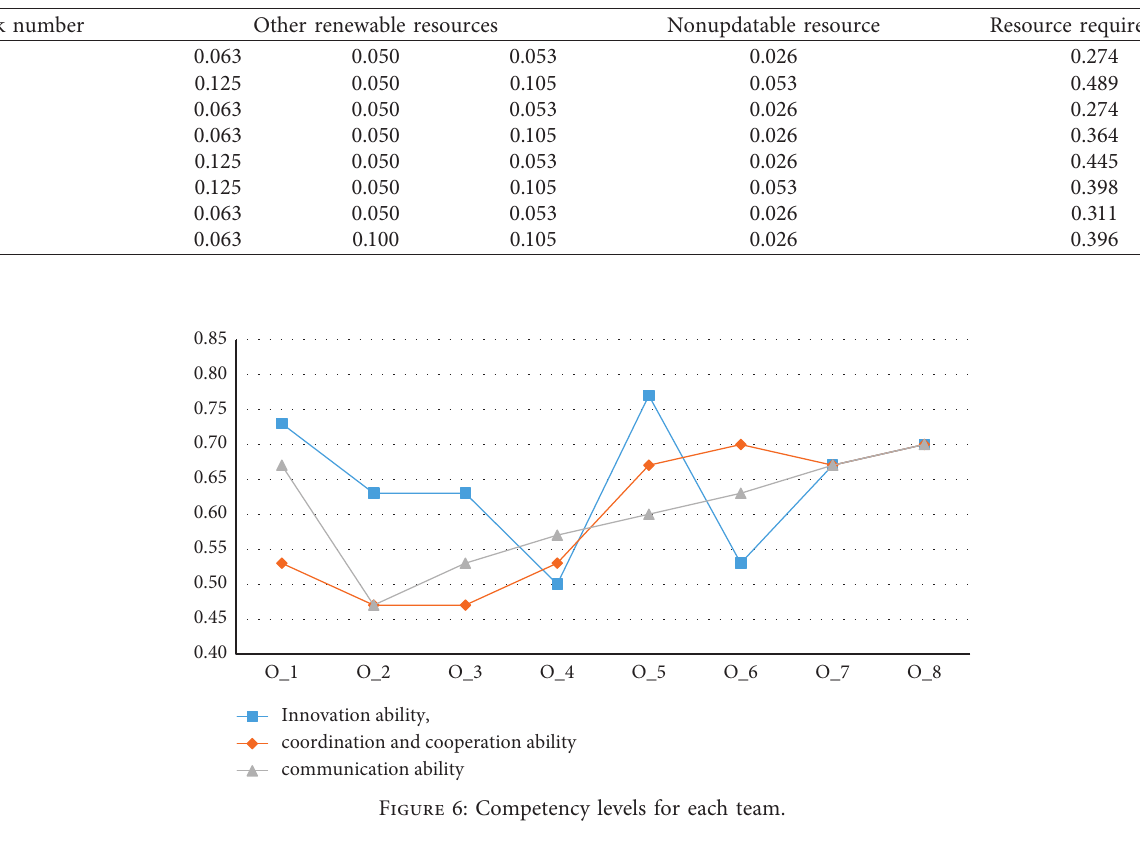
Table 5: Resource requirement information for each task.